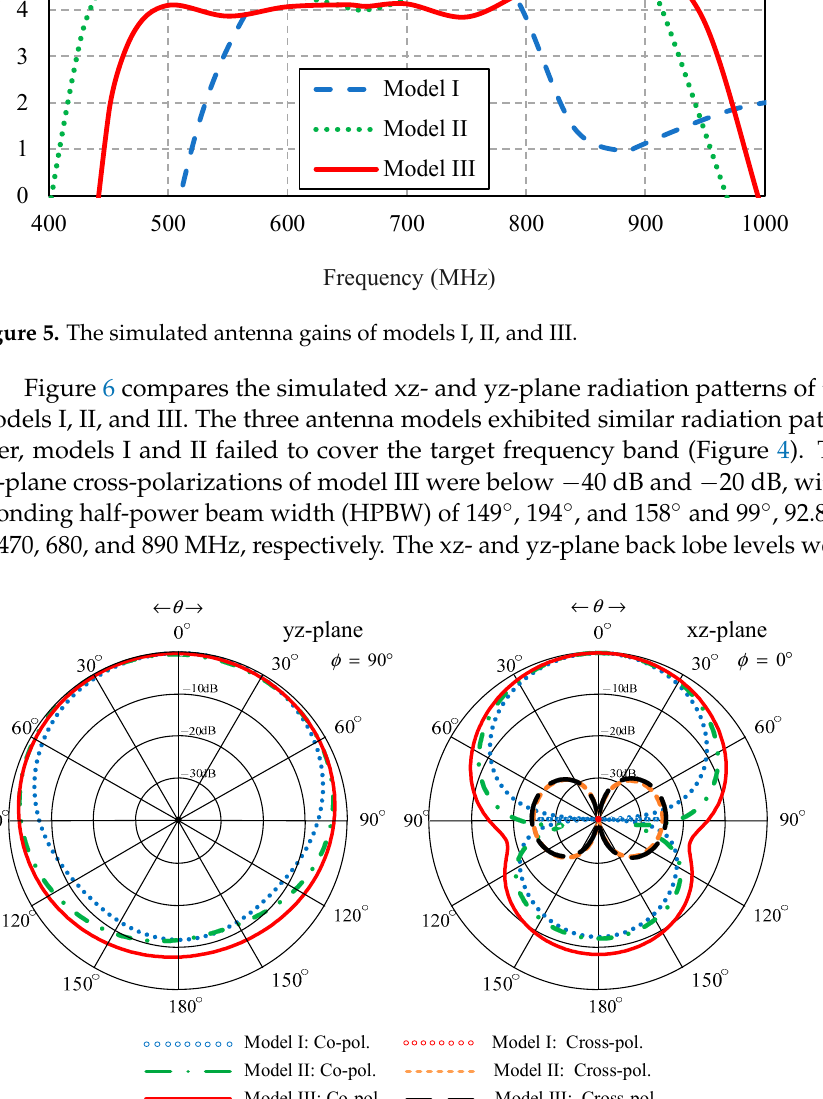
Figure 6. Simulated xz- and yz-plane radiation patterns of the antenna models I, II, and III.